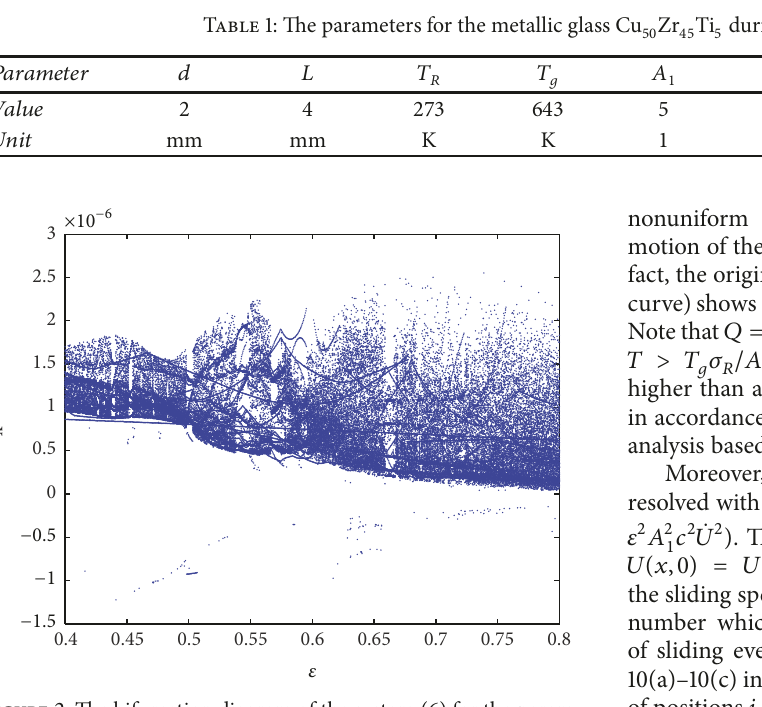
Figure 2: The bifurcation diagram of the system (6) for the param- eter 𝜀 range in [0.4,0.8],𝑄 = 1